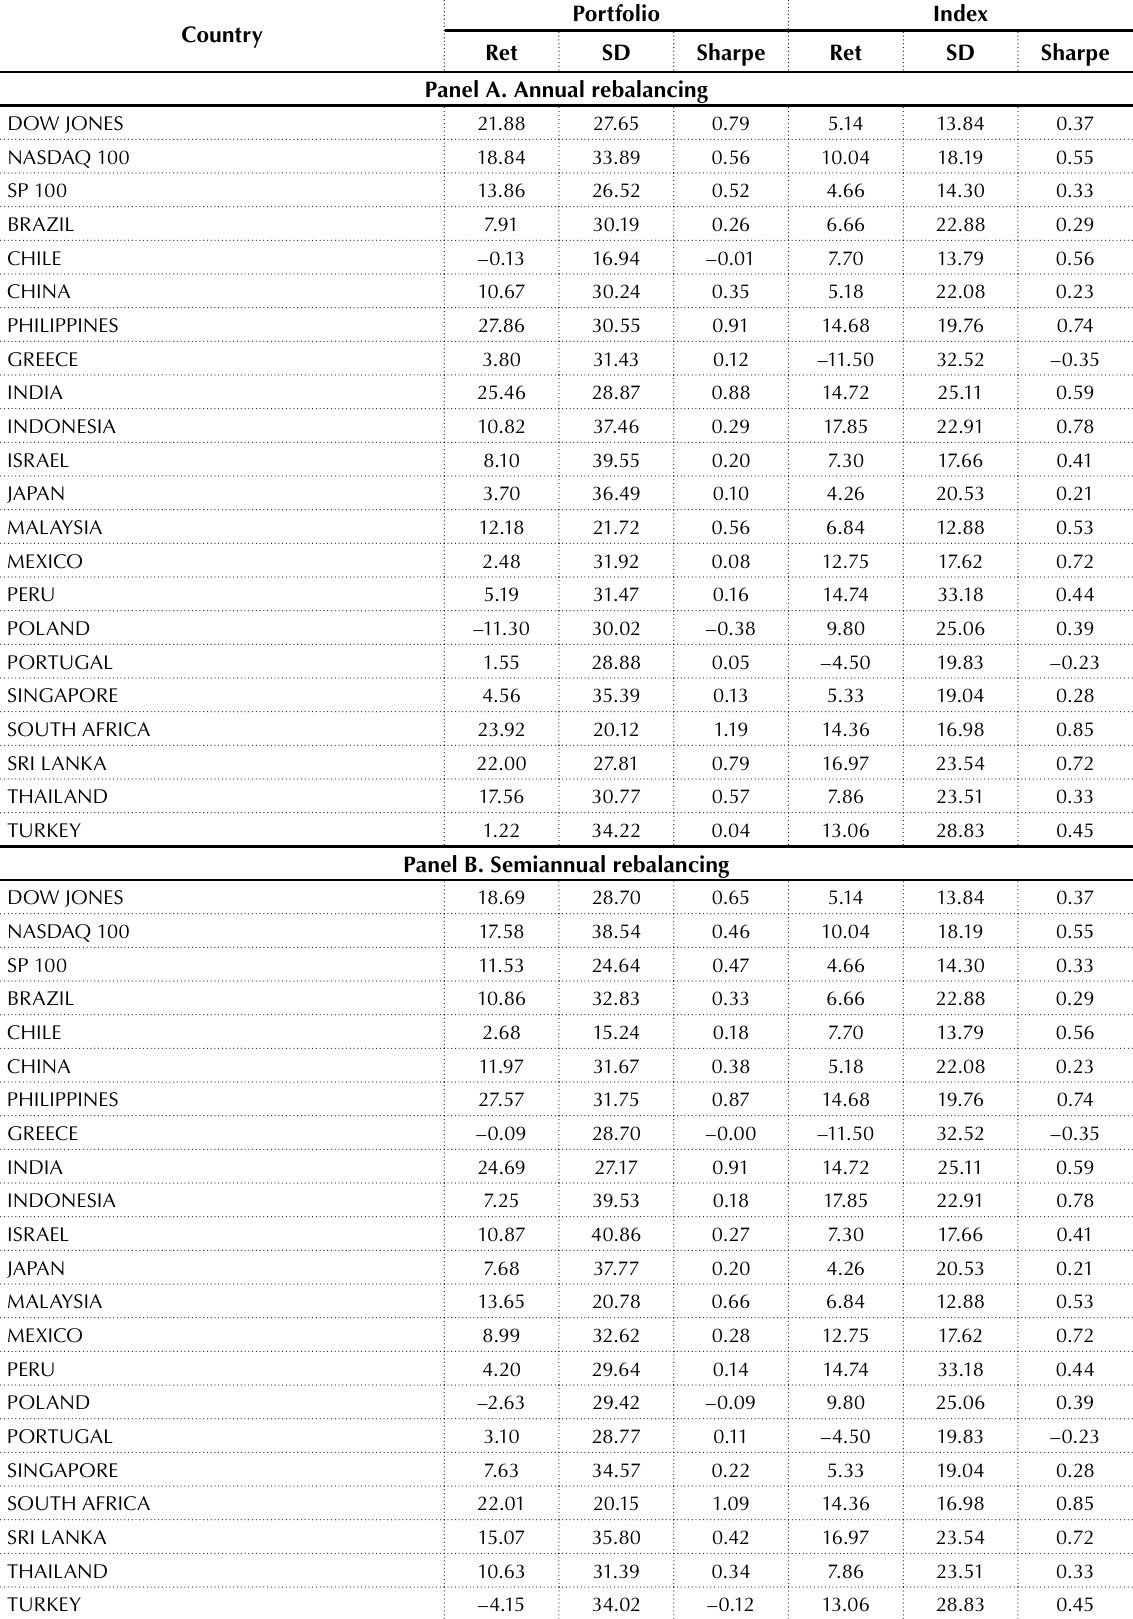
Table 2. Performance of mean-variance optimized portfolios Portfolio Index Country SD Sharpe Sharpe Panel A. Annual